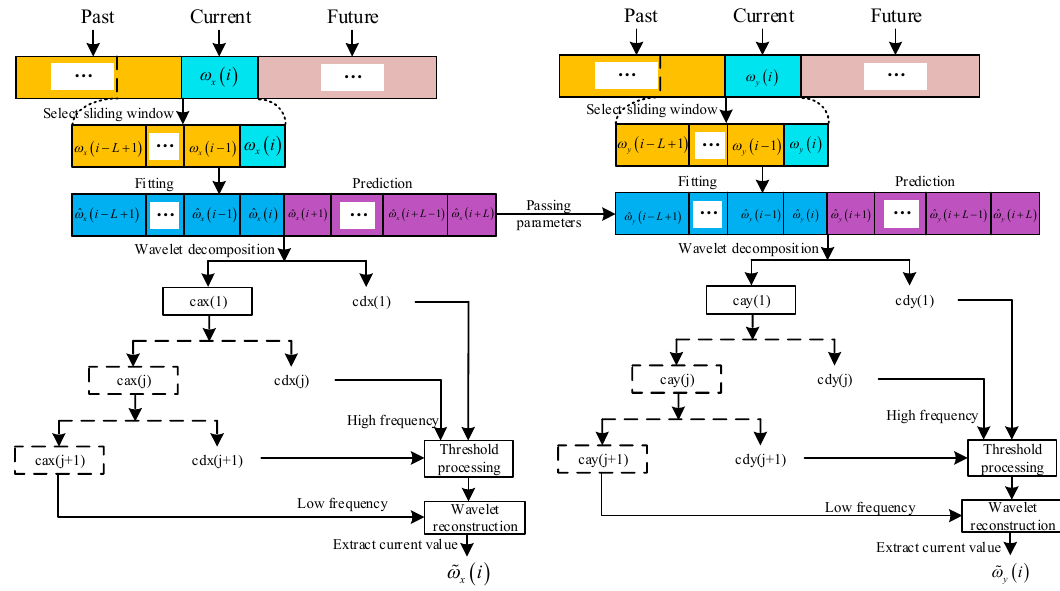
Figure 6. Flowchart of real-time wavelet threshold de-noising based on function extension.